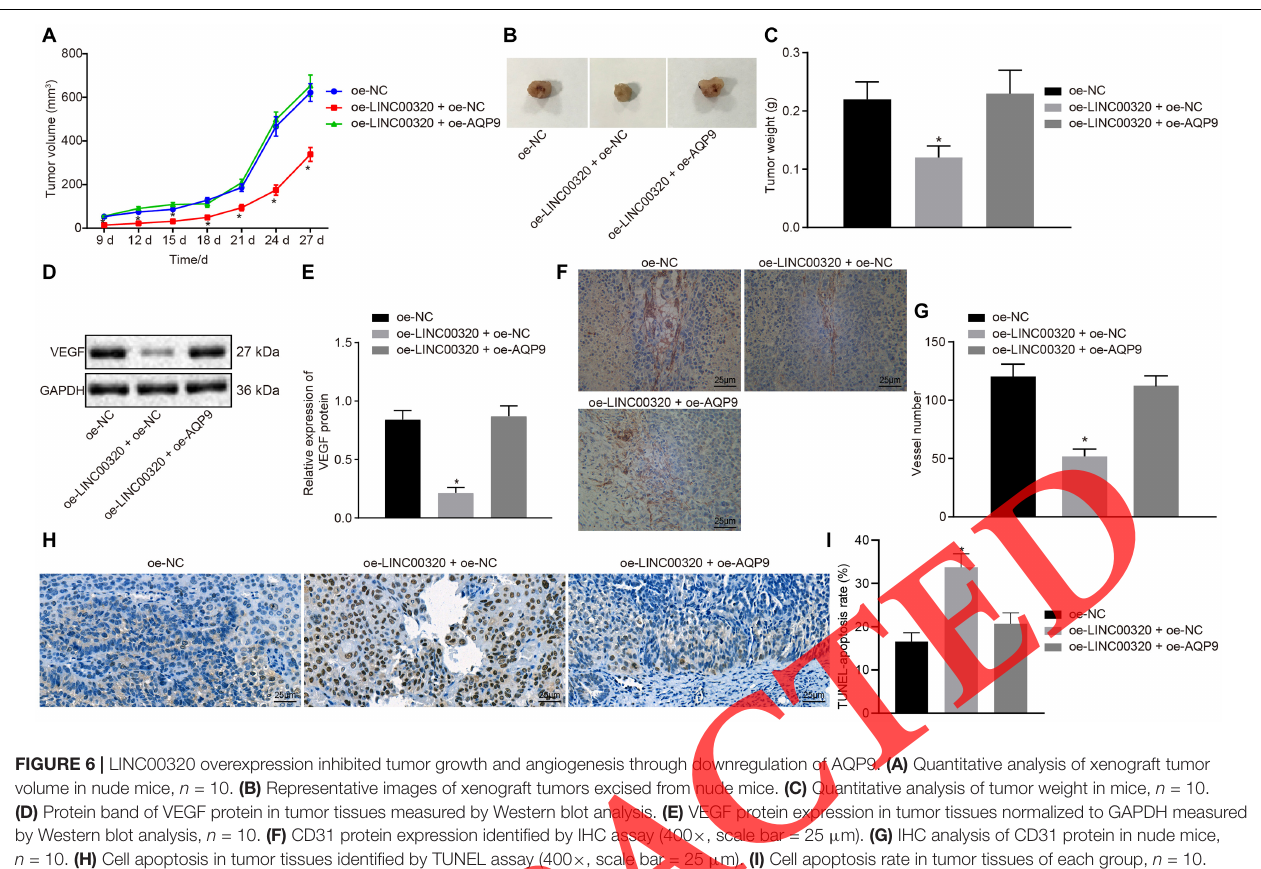
FIGURE 6 | LINC00320 overexpression inhibited tumor growth and angiogenesis through downregulation of AQP9. (A) Quantitative analysis of xenograft tumor volume in nude mice, n = 10. (B) Representative images of xenograft tumors excised from nude mice. (C) Quantitative analysis of tumor weight in mice, n = 10. (D) Protein band of VEGF protein in tumor tissues measured by Western blot analysis. (E) VEGF protein expression in tumor tissues normalized to GAPDH measured by Western blot analysis, n = 10. (F) CD31 protein expression identified by IHC assay (400 × , scale bar = 25 µ m). (G) IHC analysis of CD31 protein in nude mice, n = 10. (H) Cell apoptosis in tumor tissues identified by TUNEL assay (400 × , scale bar = 25 µ m). (I) Cell apoptosis rate in tumor tissues of each group, n = 10. * p < 0.05 vs. nude mice injected with U87 cells transfected with oe-NC. Data were expressed as mean ± standard deviation, and comparisons among multiple groups were conducted by one-way ANOVA, followed by Tukey post hoc test. The experiment was repeated three times independently.